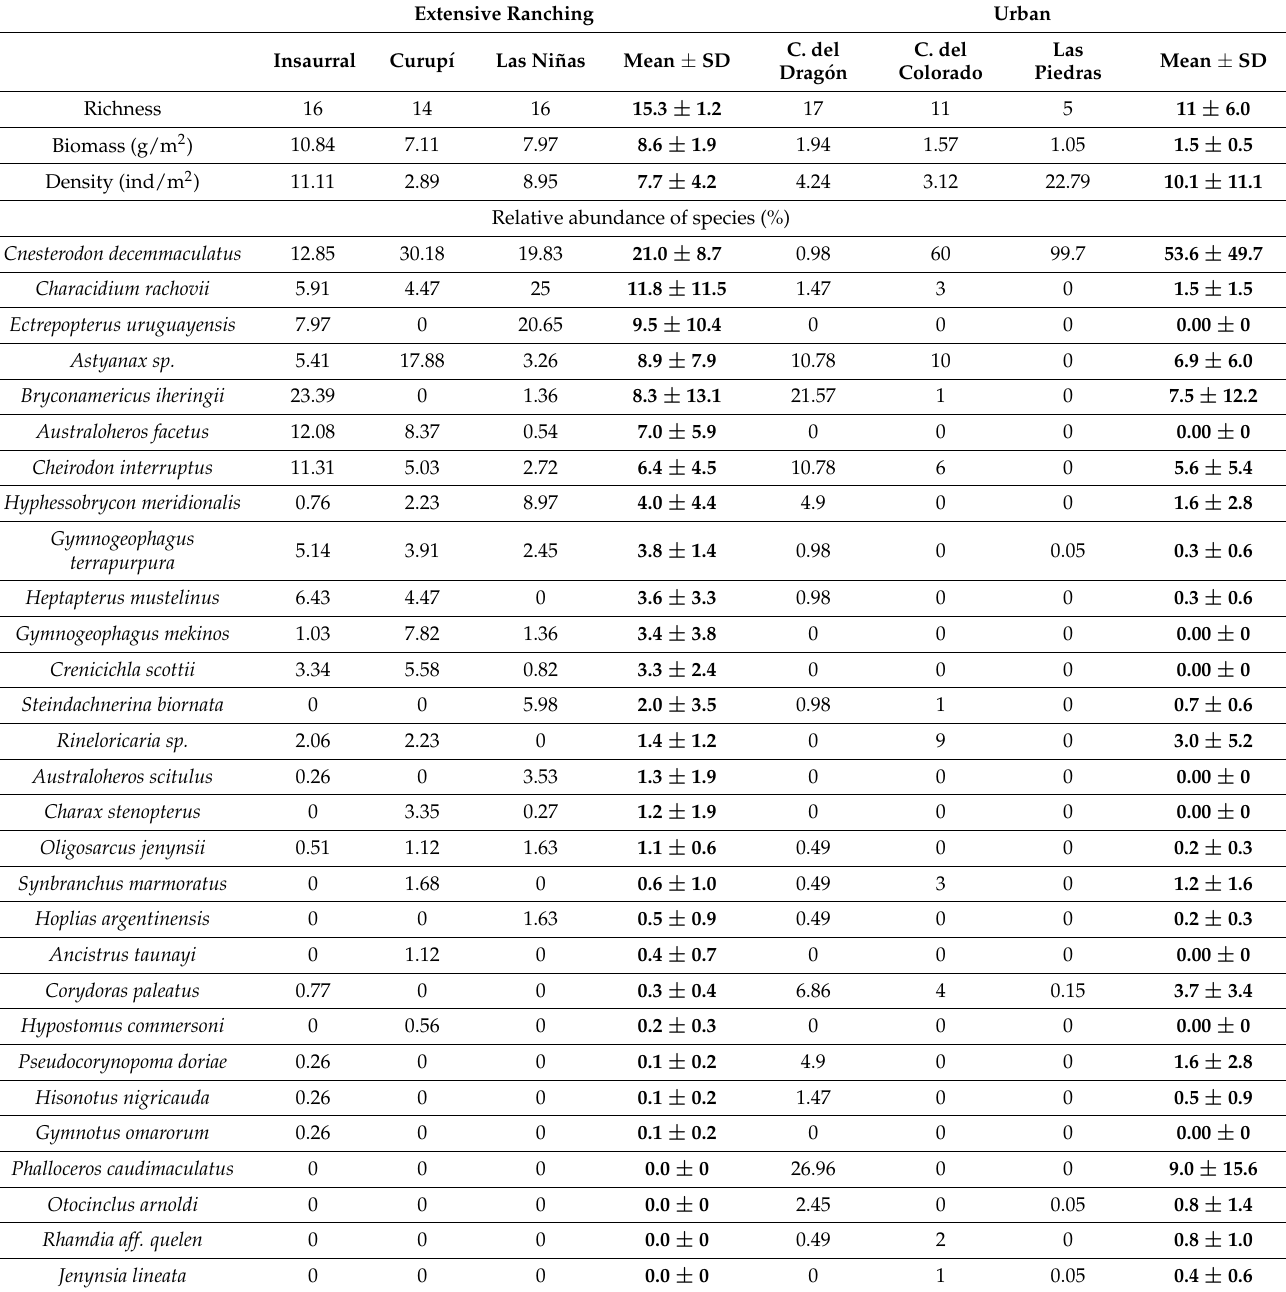
Table 2. Main characteristics of the communities of the 6 streams analyzed. Mean is presented for each stream, and mean and standard deviation (SD) per land use group. Relative abundance of each species per stream is